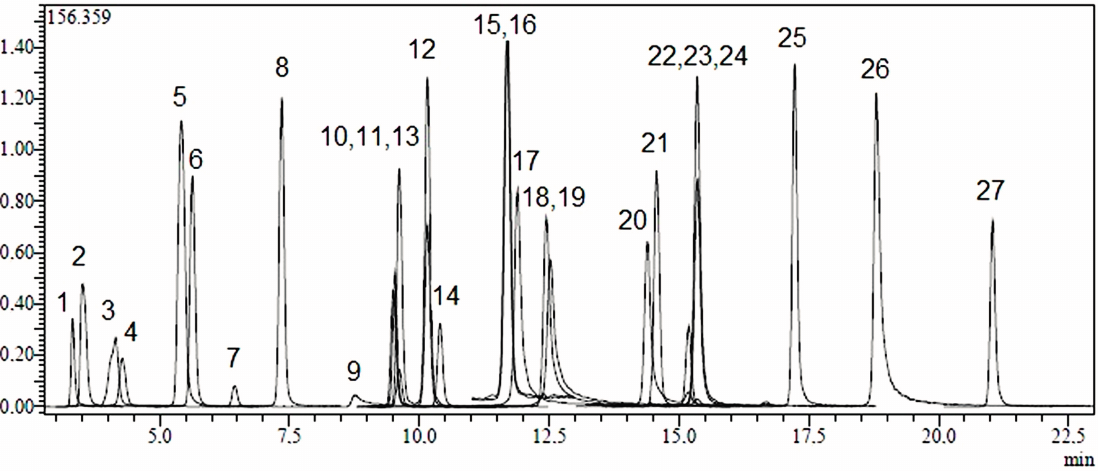
Figure 1. LC-MS/MS chromatograms of 250 ppb standard mix. Notes: Chromatographic conditions were given in Experimental section. Standard compounds: 1: quinic acid, 2: malic